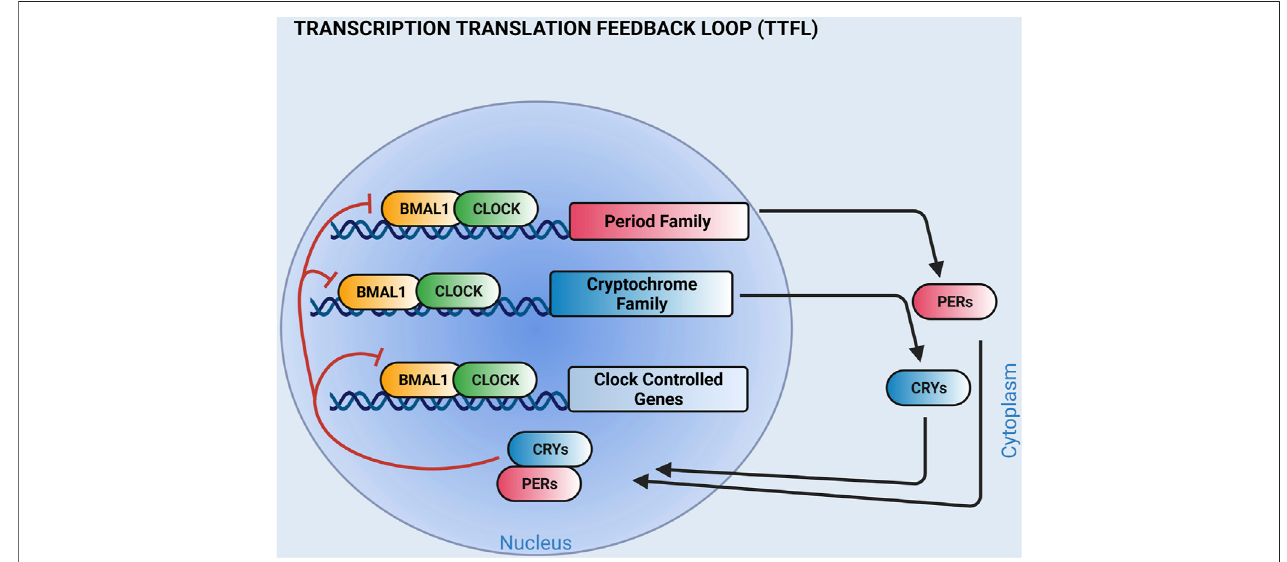
FIGURE 1 | The molecular clock isa transcription translation feedback loop. Shown is a simpli fi ed cartoon of the circadian clock mechanism. BMAL1 and CLOCK transcriptionfactorheterodimersbindE-boxes onthepromoters ofPeriod(PER1,2,3) andCryptochrome(CRY 1,2)family members toactivatetranscription.PERand CRYproteinsdimerizeandnegativelyfeedbackonBMAL1andCLOCK.Thecircadianclockmechanismalsoregulatesthetissue-speci fi cexpressionofclock-controlled genes. Additional feedback loops that contribute to the circadian clock mechanism are not shown. (Created with BioRender.com).